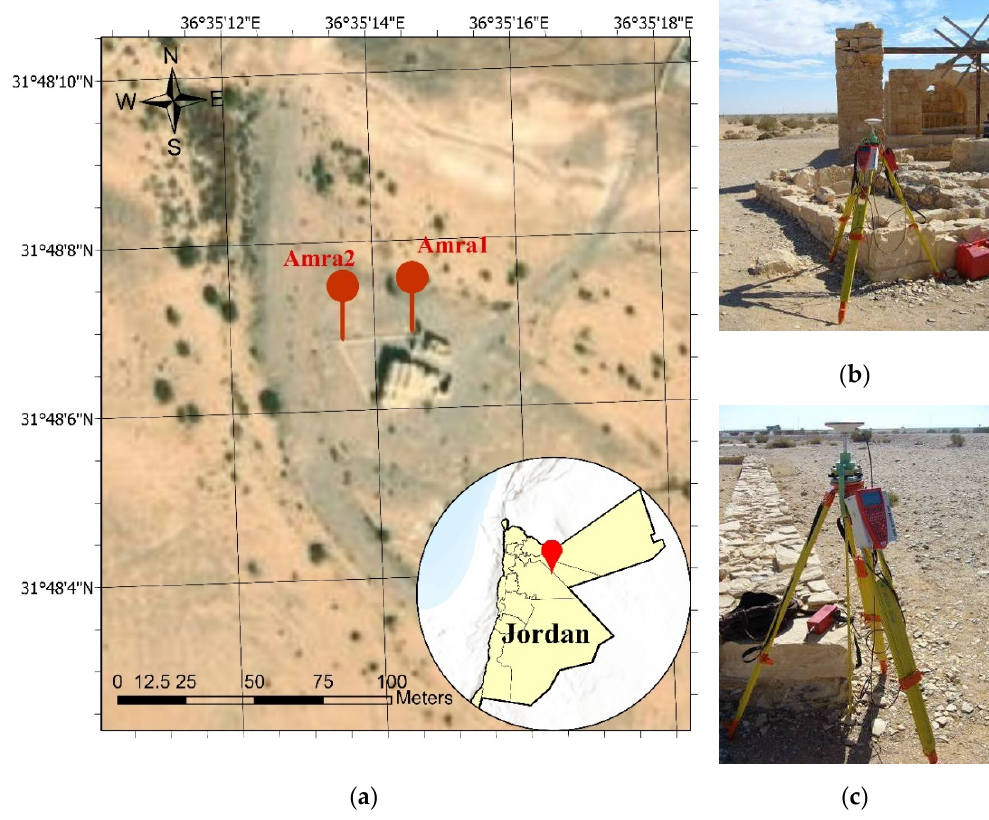
Figure 6. Reference stations: ( a ) Location of the reference stations for Qaser Amra; ( b ) Location of Amra1; ( c ) Location of Amra2.